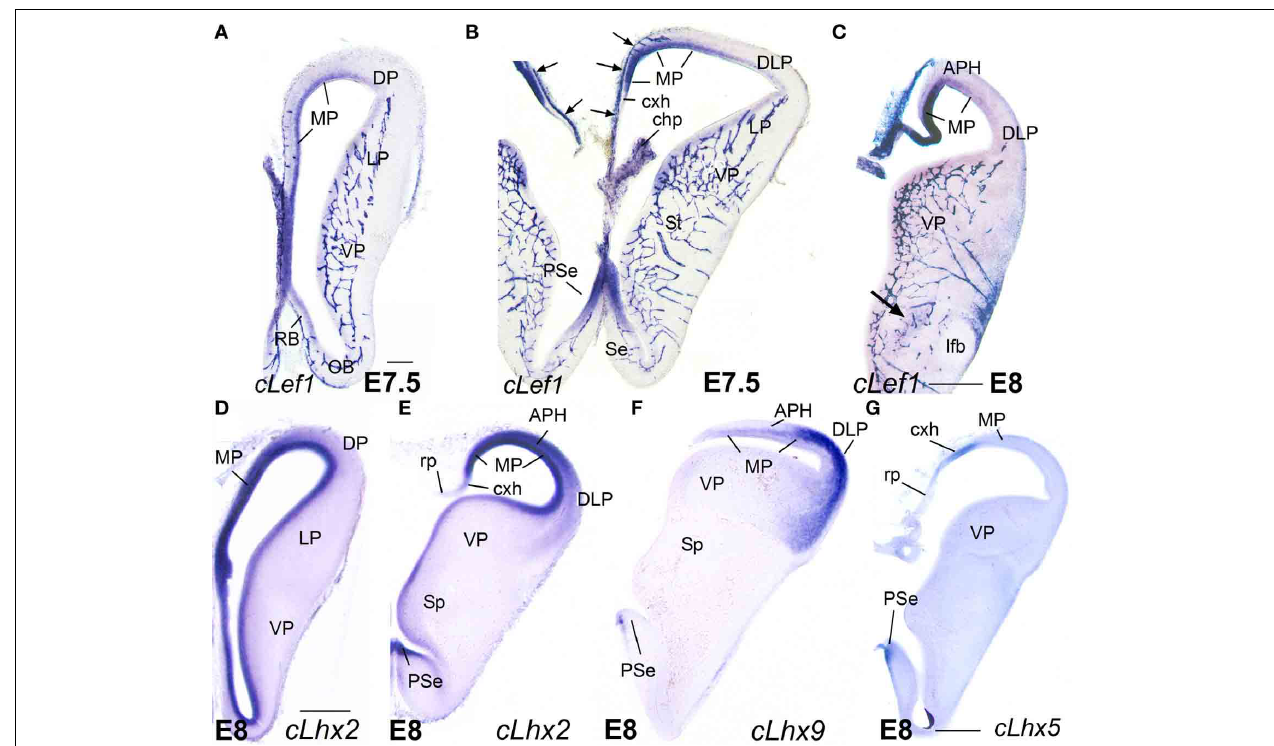
FIGURE 6 | Expression of cLef1, cLhx2, cLhx9, and cLhx5 in chicken embryonic telencephalon at early stages. Digital images of coronal sections of chicken embryonic telencephalon (E7.5 or E8), at rostral (A,D) or intermediate (B,C,E–G) levels, hybridized for cLef1, cLhx2, cLhx9 , or cLhx5 . Note the moderate to strong expression of cLef1, cLhx2 , and cLhx9 in the ventricular zone of the medial pallium (MP) and pallial septum (PSe). The pallial septum also expresses cLhx5 . From E8, the dorsolateral